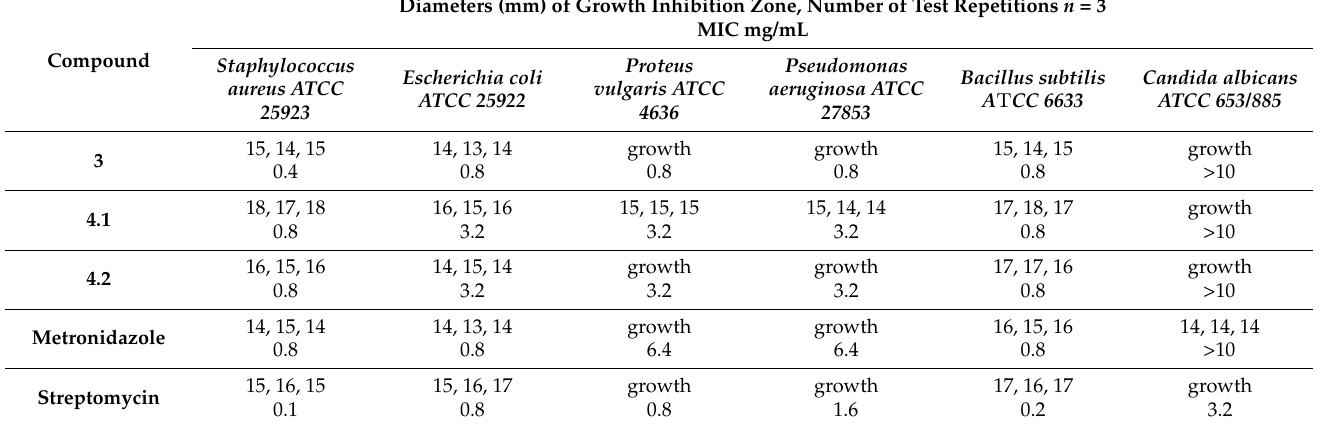
Table 1. Antimicrobial activity of 6-(imidazo[1,2- a ]pyridin-2-yl)-5-methyl-3-phenylthieno[2,3-